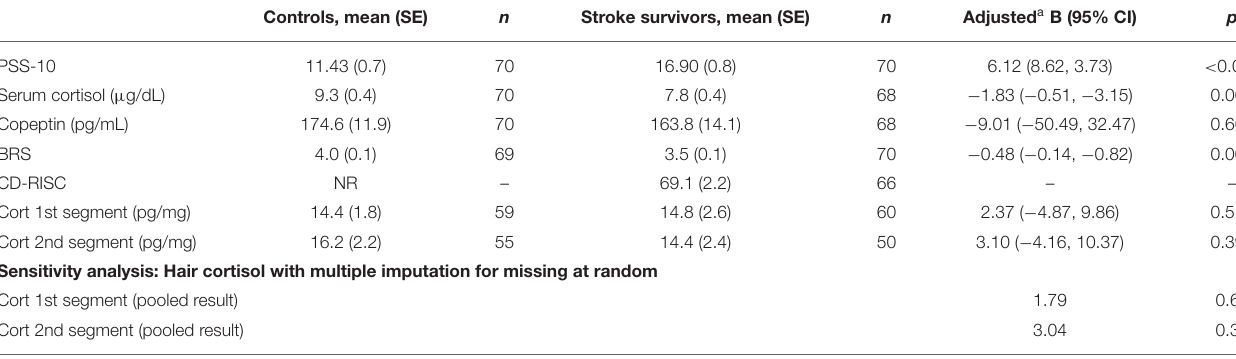
TABLE 2 | Comparison of stress and resilience measures between controls and stroke survivors.